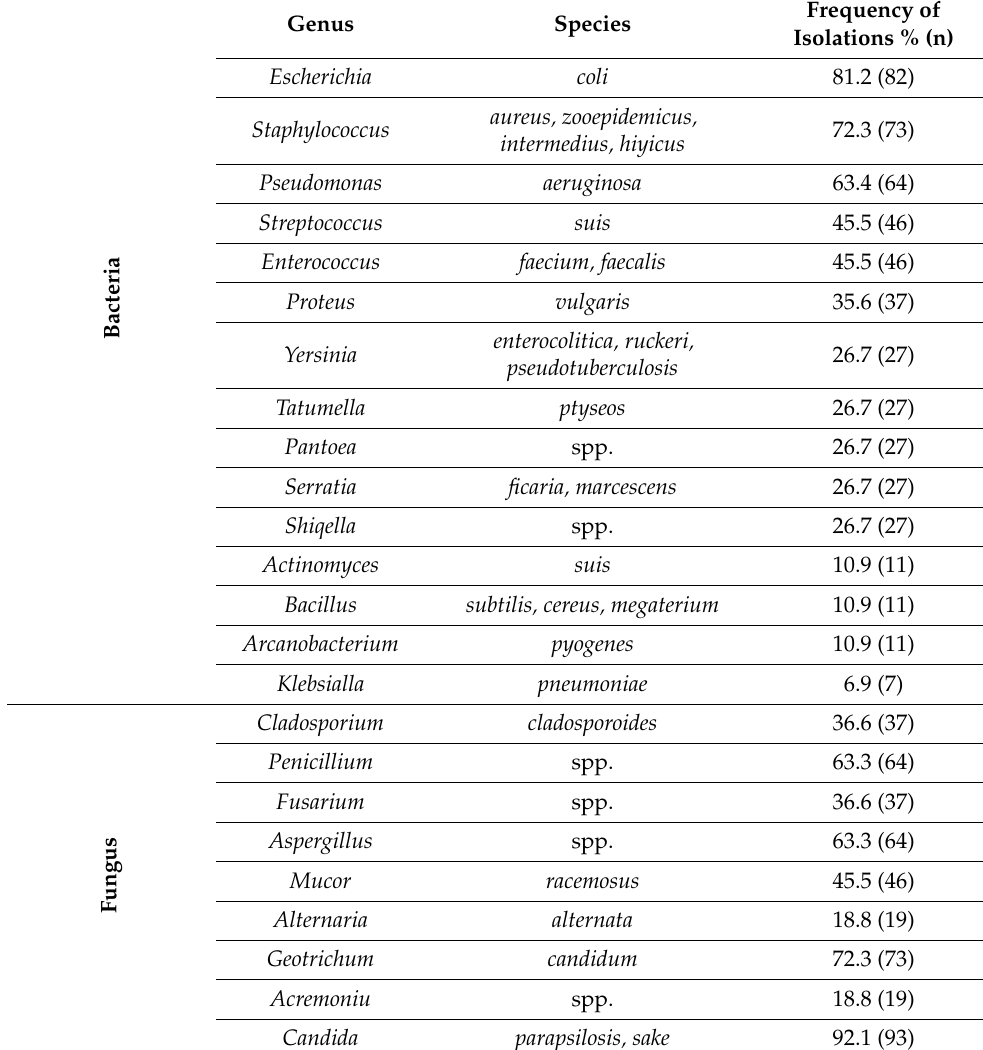
Table 2. Frequency of bacterial and fungal species isolated from boar semen.